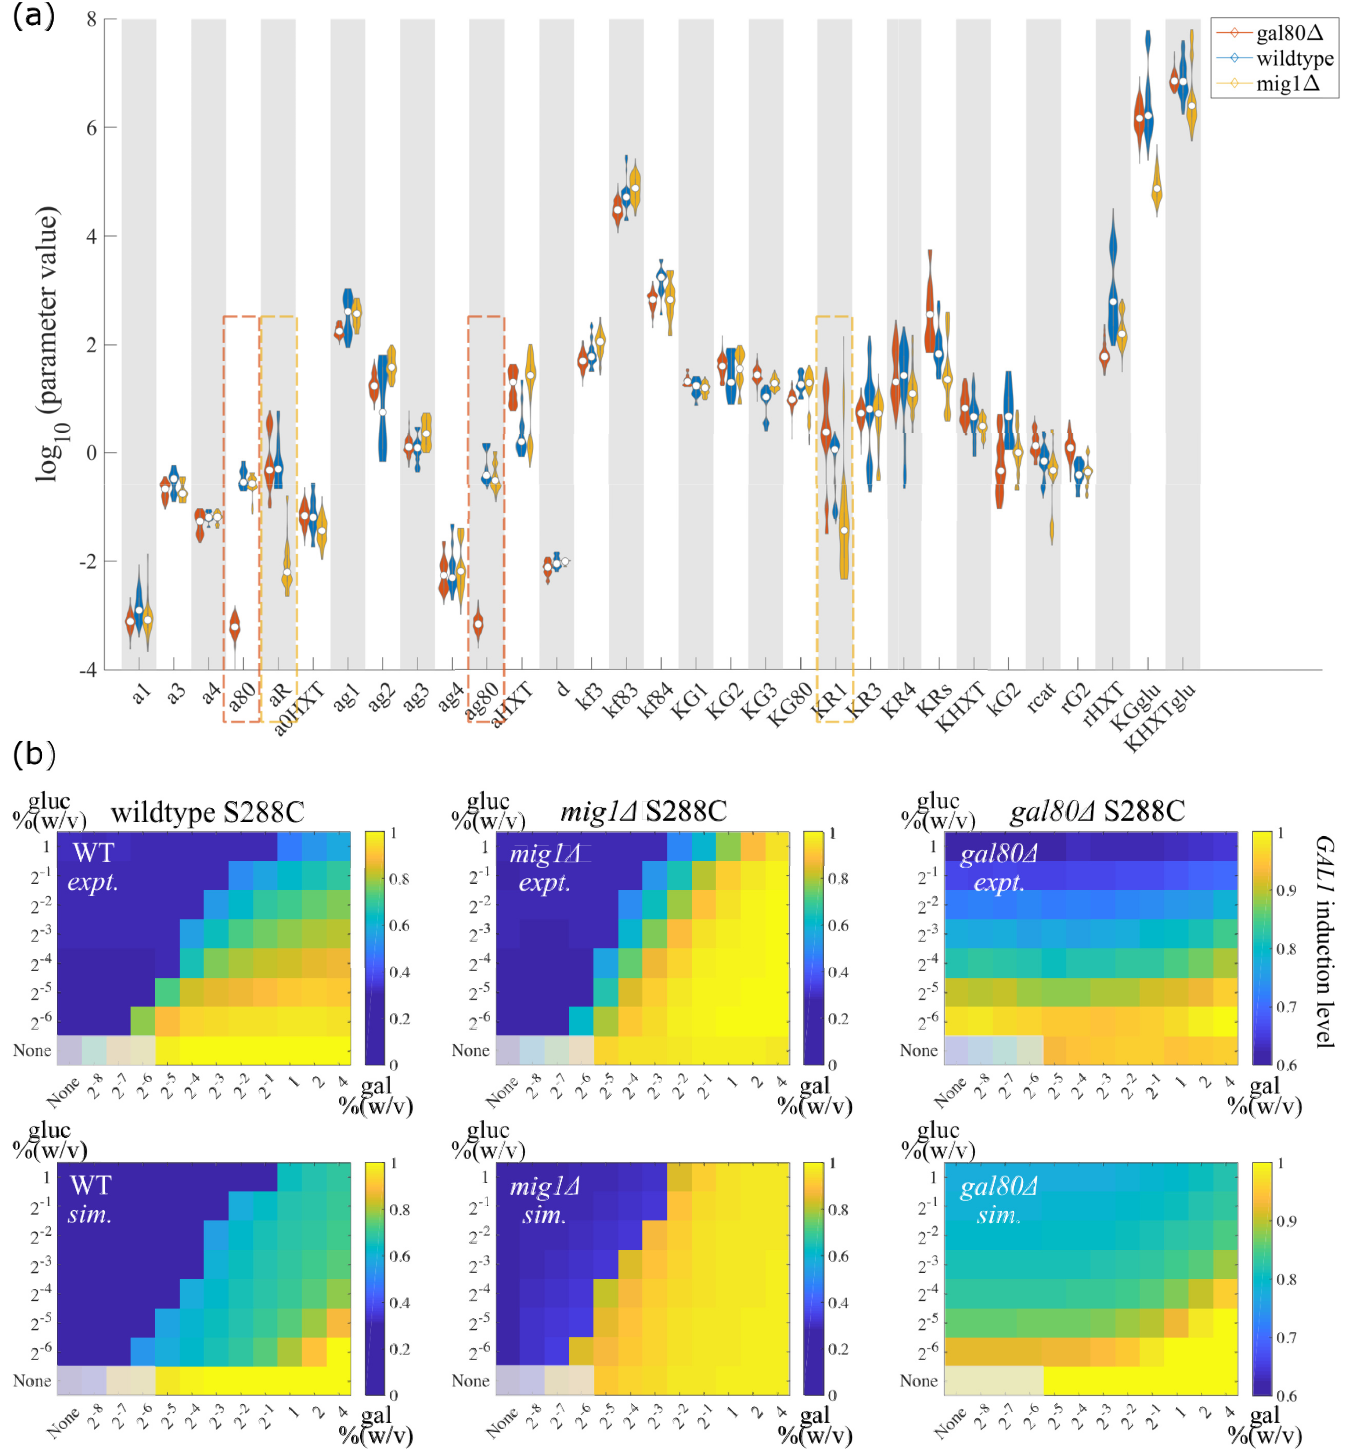
Fig 2. Using mechanistic model to capture phenotypes in wildtype and mutant S288C strains. (a) Parameter choices are consistent in wildtype and synthetic deletion strains of S288C. The horizontal axis shows the free parameters that we allowed to vary in the fitting for wildtype S288C (wildtype), for gal80 Δ synthetic deletion strain ( gal80 Δ ), and for mig1 Δ synthetic deletion strain ( mig1 Δ ). The vertical axis shows the parameter values that were able to fit wildtype and mutant S288C strains separately. Most parameter values overlapped among the three strains, except parameters corresponding to synthetic deletions, including a80, the basal synthesis rate of Gal80p, ag80, the maximum synthesis rate of Gal80p (both highlighted in red dashed boxes), and aR, the synthesis rate of Mig1p, KR1, GAL1 transcriptional